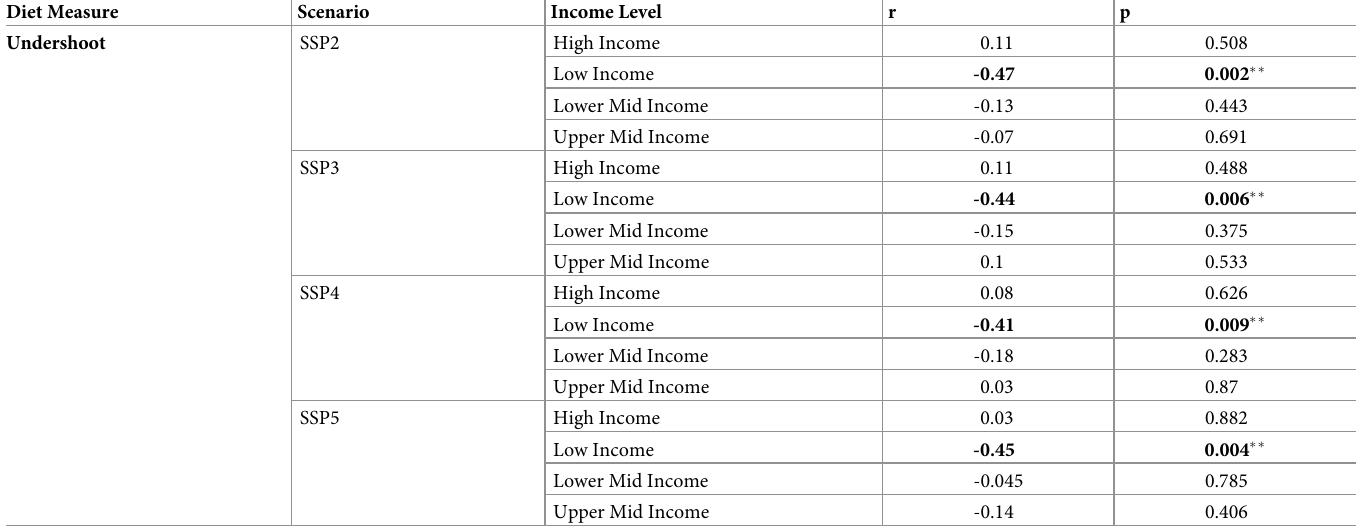
Table 5. Cross-country correlations tracking the change in country-level undershoot (arithmetic mean of food group category-level overshoot) between 2010 and 2050 and the change in imports per capita between the years 2010 and 2050. Income regions are constructed via global income quartiles, and are roughly analogous